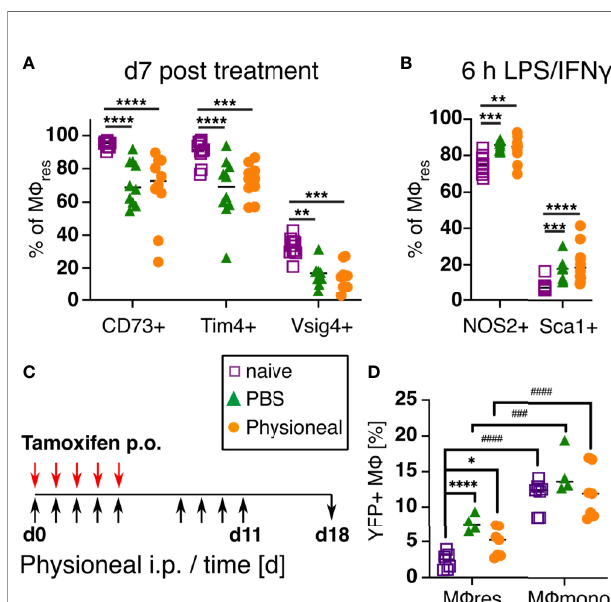
FIGURE 6 | PD fl uid conditioned M F res maintain altered activation phenotype after treatment is discontinued while remaining largely